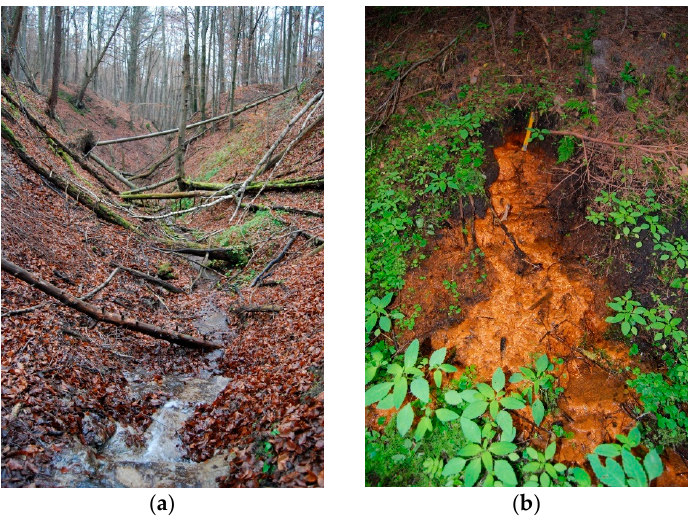
Figure 7. Examples of landforms: ( a ) Duble´n Ravines, ( b ) spring niche of ferruginous water.